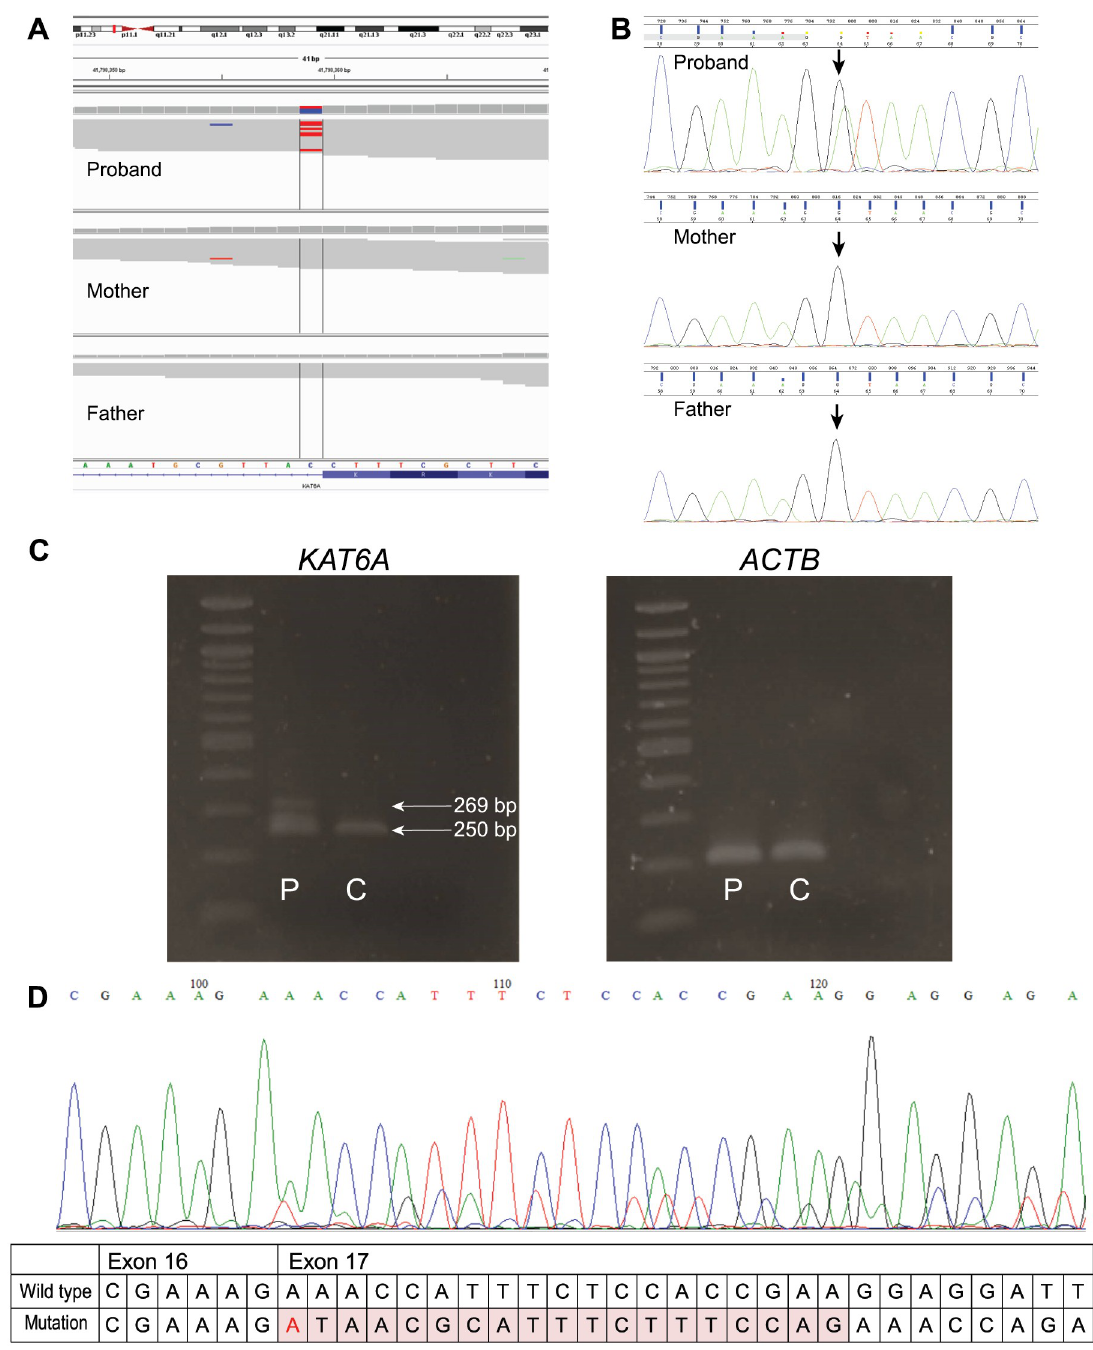
Fig 2. Analysis of the c.3039+1G > A splice variant. A—IGV image illustrating presence of de novo splice variant c.(3039+1G > A) in KAT6A , identified in patient 3 and absent in parents. B—Electropherograms showing presence of c.(3039+1G > A) in DNA of proband (G/A) and absence in both parents (G/G) C—RT-PCR of KAT6A and actin ( ACTB ) cDNA transcripts of patient 3 (P) and a healthy control (C). D—The functional effect of c.(3039+1G > A) splice variant in patient 3, which was identified by sequencing the cDNA product from RNA extracted from patient’s lymphoblastoid cell lines. The splice donor variant resulted in the intron retention of 19bp and a frameshift